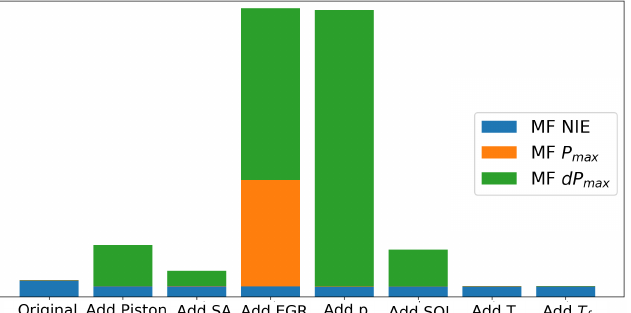
Figure 22. Influence of different parameters on the objective